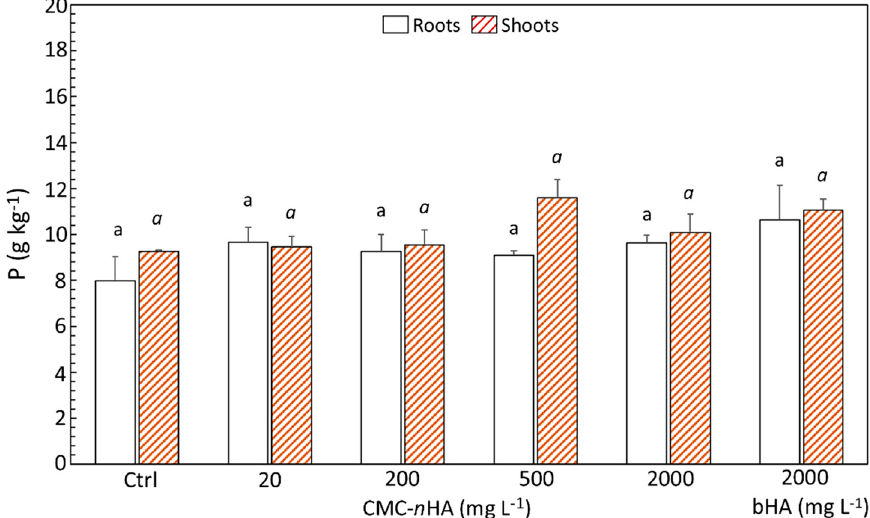
Figure 7. P concentration (g kg − 1 ) in the roots and shoots of S. lycopersicum seedlings. Bars represent the mean standard deviation. Different letters indicate statistically significant differences between treatments (Mann-Whitney (MWW) test, p ≤ 0.05).